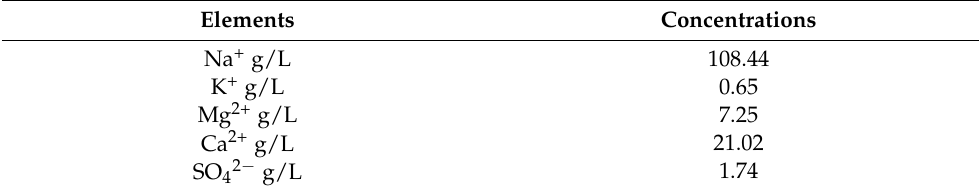
Table 6. Chemical composition of salinity